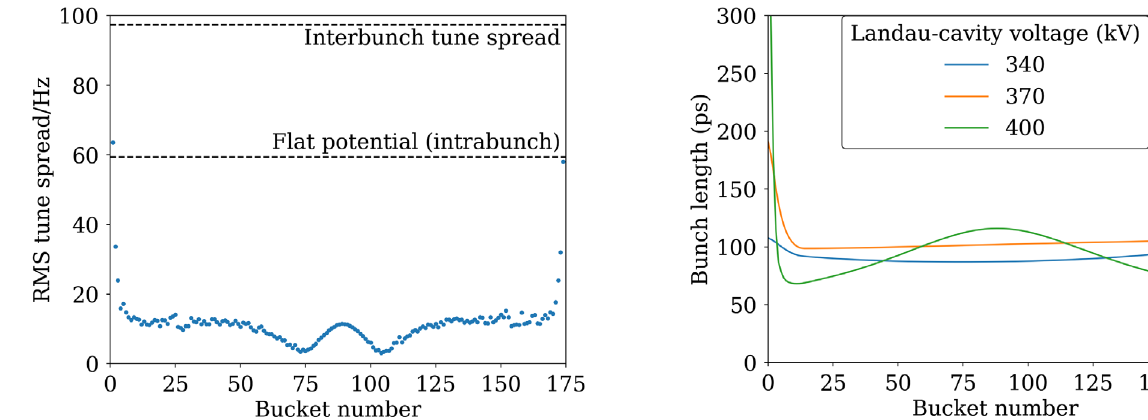
FIG. 12. Intrabunch RMS synchrotron tune spread within each bunch with 402 kV Landau-cavity voltage.